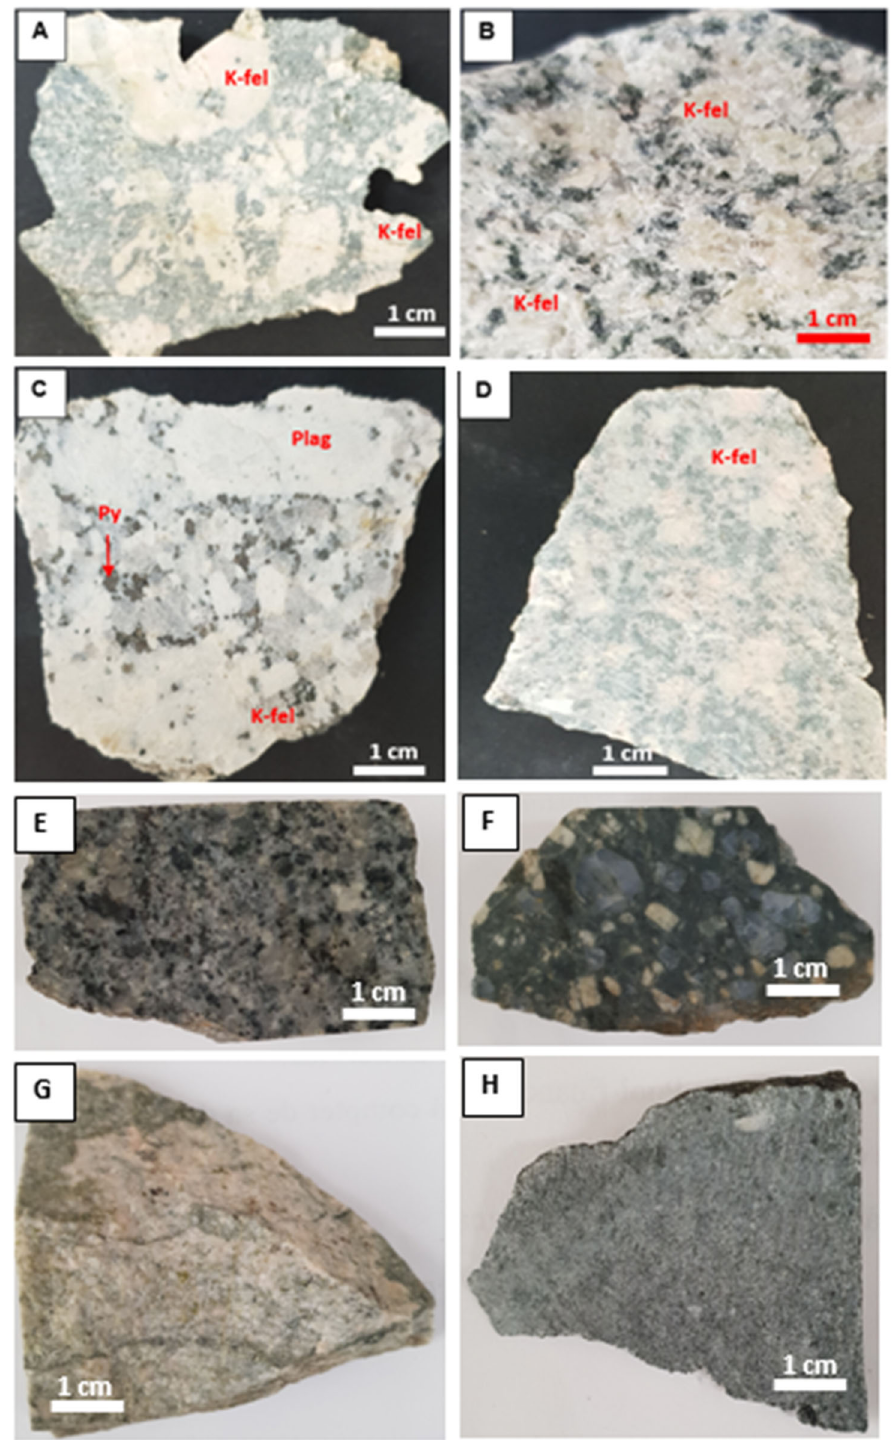
Figure 6. Selected granitoid rock samples from Malaysia on which the Pb isotope of K ‐ feldspar was undertaken. ( A ) Hand specimen of megacrystic granite from the Bentong area (sample: BE ‐ 11513). ( B ) Granite GM ‐ 0113. ( C ) Granite GRL0313. ( D ) Granite GM0213. Samples that contain pyrite used to determine Pb isotope composition are hand specimens as displayed in images ( E ) Granodiorite (sample BG ‐ 0313); ( F ) Diorite with phenocrysts of plagioclase and quartz; ( G ) Rhyolite and ( H ) Dolerite. Plag = Plagioclase, K ‐ fel = K feldspar, Py = Pyrite.